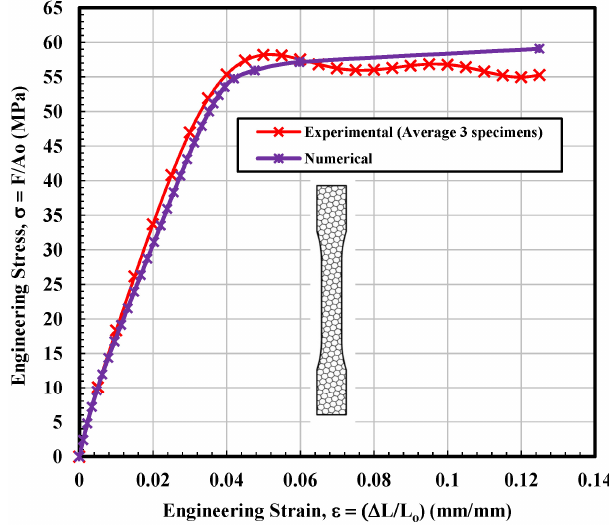
Figure 13. Engineering stress–strain curves for diamond tested specimens based on experimental and finite element analysis.